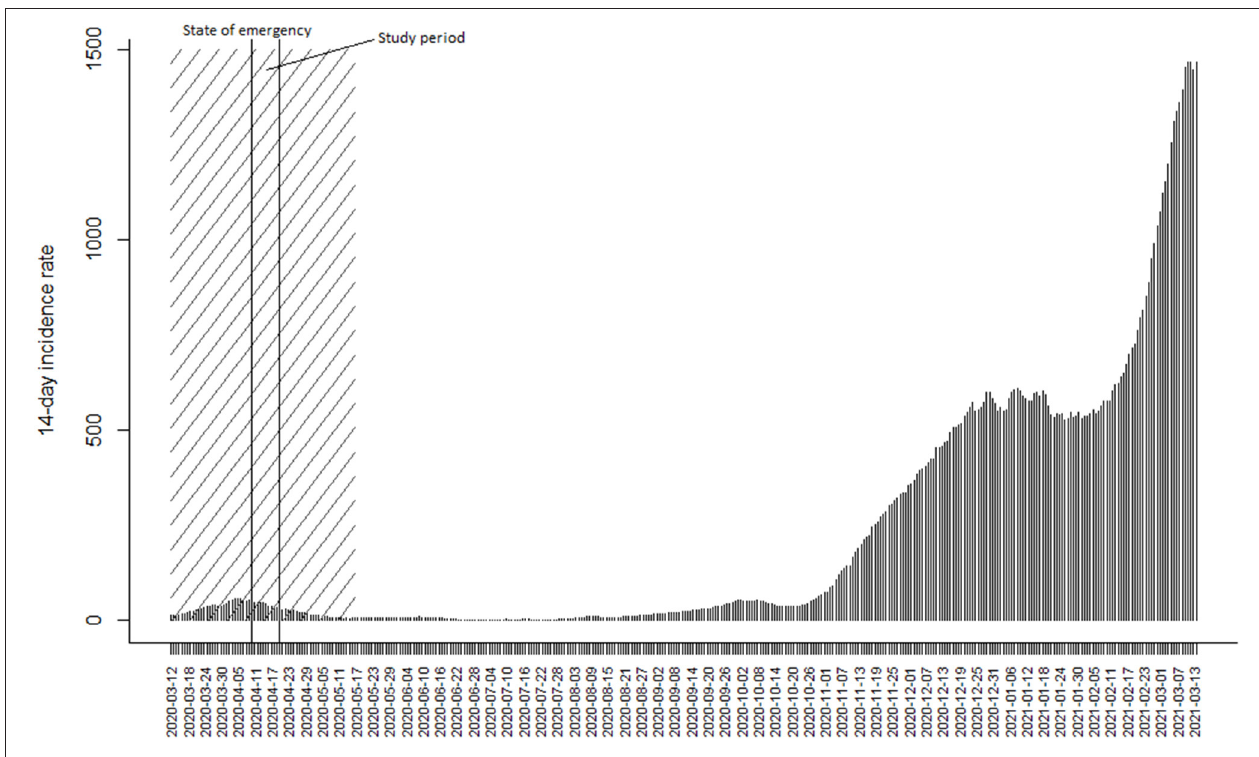
FIGURE 1 | The 14-day incidence rate for COVID-19 cases per 100,000 over a 1-year period in Estonia.